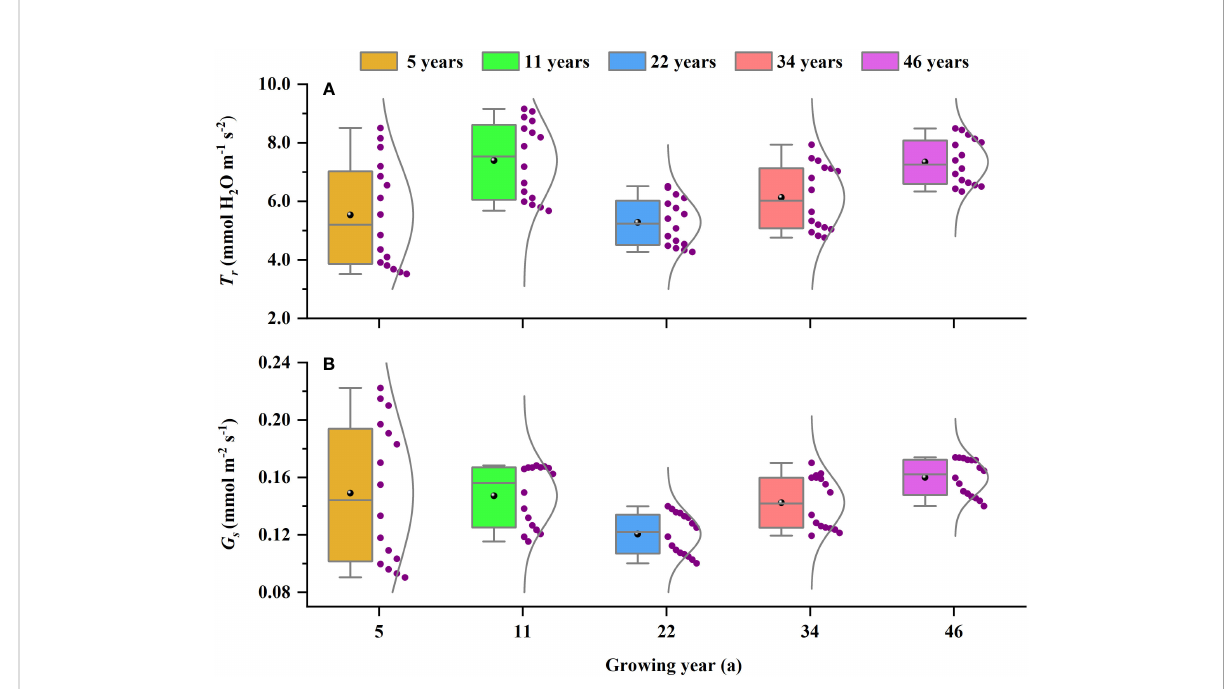
FIGURE 5 The variations in (A) T r and (B) G s at different planting ages. The purple dots represent the values of T r and G s under different light intensities. T r , transpiration; G s , stomatal